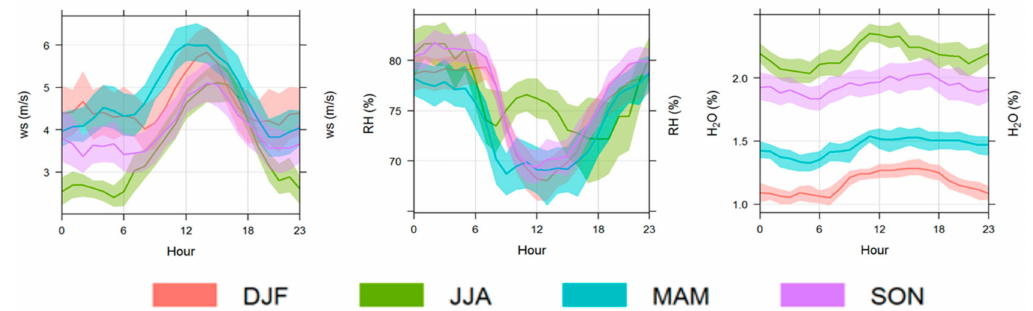
Figure 5. Seasonal average diurnal variation of wind speed (WS), relative humidity (RH) and water vapor (H 2 O) at CGR during one full year. Dashed areas denote the 96% confidence levels. Time is expressed in local time (UTC + 1) (adapted by